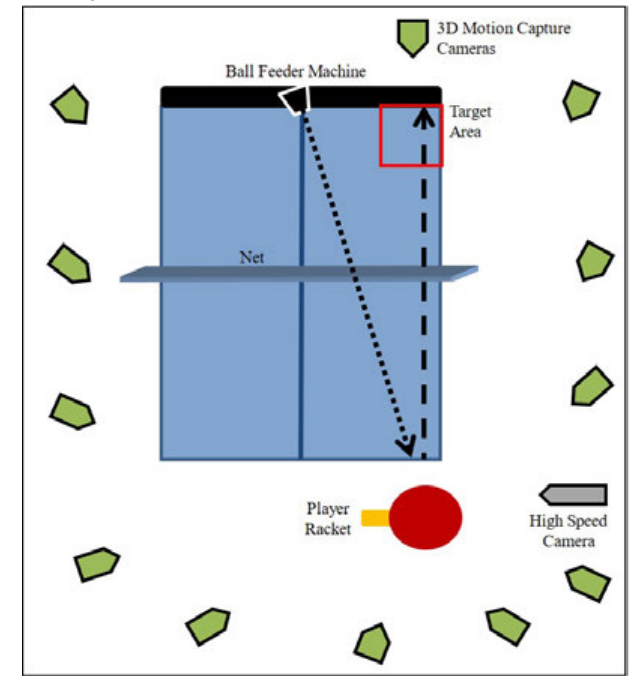
Figure 3. Experimental Set-Up A 12-camera three-dimensional motion capture system (VICON MX series., Oxford, UK) captured the forehand topspin technique performed by the players at 500 Hz. Reflective spherical markers of 14 mm diameter were attached to the bilateral anterior superior iliac spines and bilateral posterior superior iliac spines (Figure 4) to define mid-pelvis of the players. This allowed the measurement of horizontal and vertical distances at racket-ball impact from the hitting side of the table-tennis table whereby the playing area was defined by four markers. Players used their own racket, where four reflective markers were attached to the lateral aspects, top and bottom of the racket to measure racket kinematics and racket-ball impact angle. The three-dimensional coordinates were expressed as a right-handed orthogonal reference frame fixed on the table (Z was vertical and pointed upwards, Y was horizontal and pointed to the centre of the target, while X was perpendicular to Y and